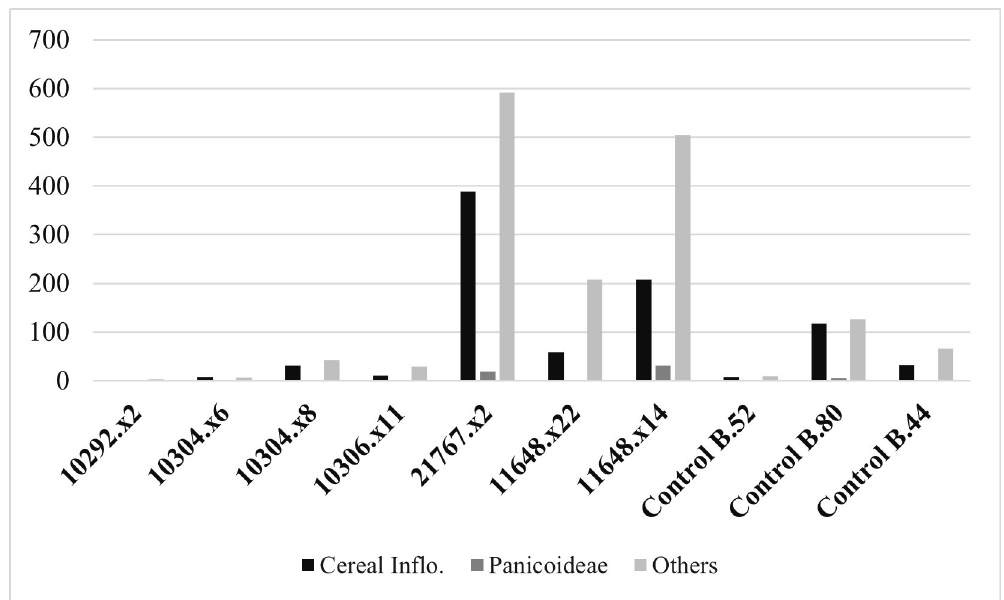
Fig 8. Phytoliths groups by artefact. Raw count comparison of phytoliths from cereals, Panicoideae and others, including cells from leaves and culms.